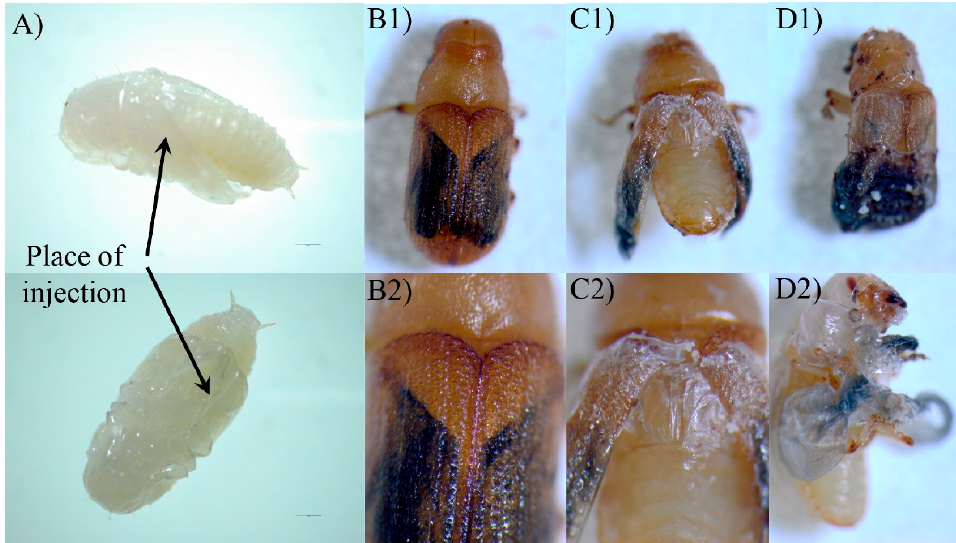
Figure 9. Biological morphology of D. armandi from the pupa to adult stage. ( A ) Arrows point to the place of pupa injection; ( B1 , B2 ) normal adult morphology in the control group; ( C1 , C2 ) abnormal morphology of adult D. armandi that were treated with dsAST; ( D1 , D2 ) abnormal morphology of adult D. armandi after dsJHAMT treatment.